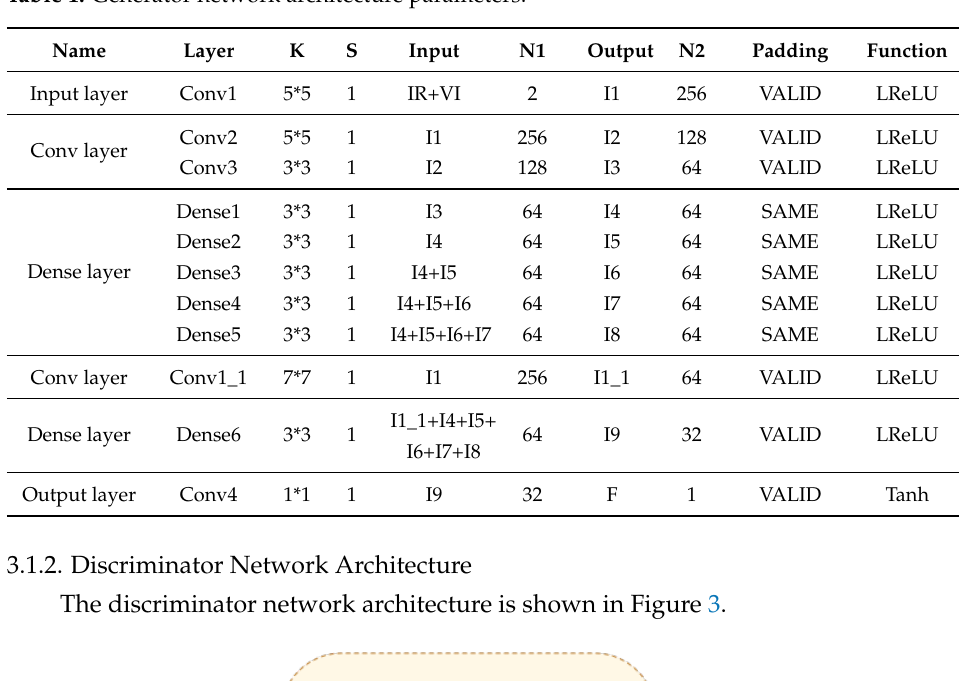
Table 1. Generator network architecture parameters.